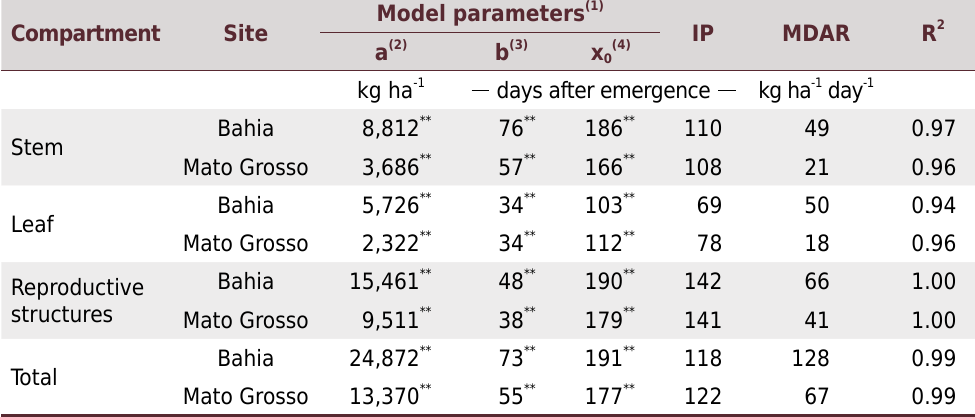
Table 2. Estimation of fitted model parameters for shoot dry matter accumulation and respective inflection point (IP), maximum daily accumulation rate (MDAR), and coefficient of determination (R 2